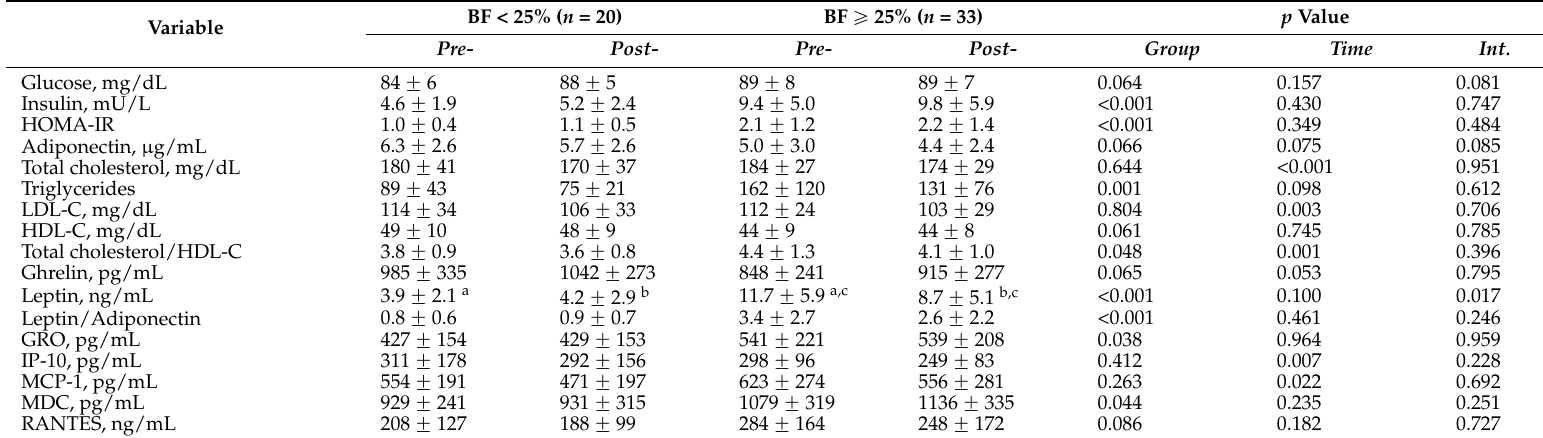
Table 3. Biomarkers of glucose metabolism, lipid profiles, appetite and energy homeostasis and inflammation in non-obese and obese submariners before and after a 3-month patrol. BF < 25% ( n = 20) BF ě 25% ( n = 33) p Value Variable Pre- Post- Pre- Post- Group Time